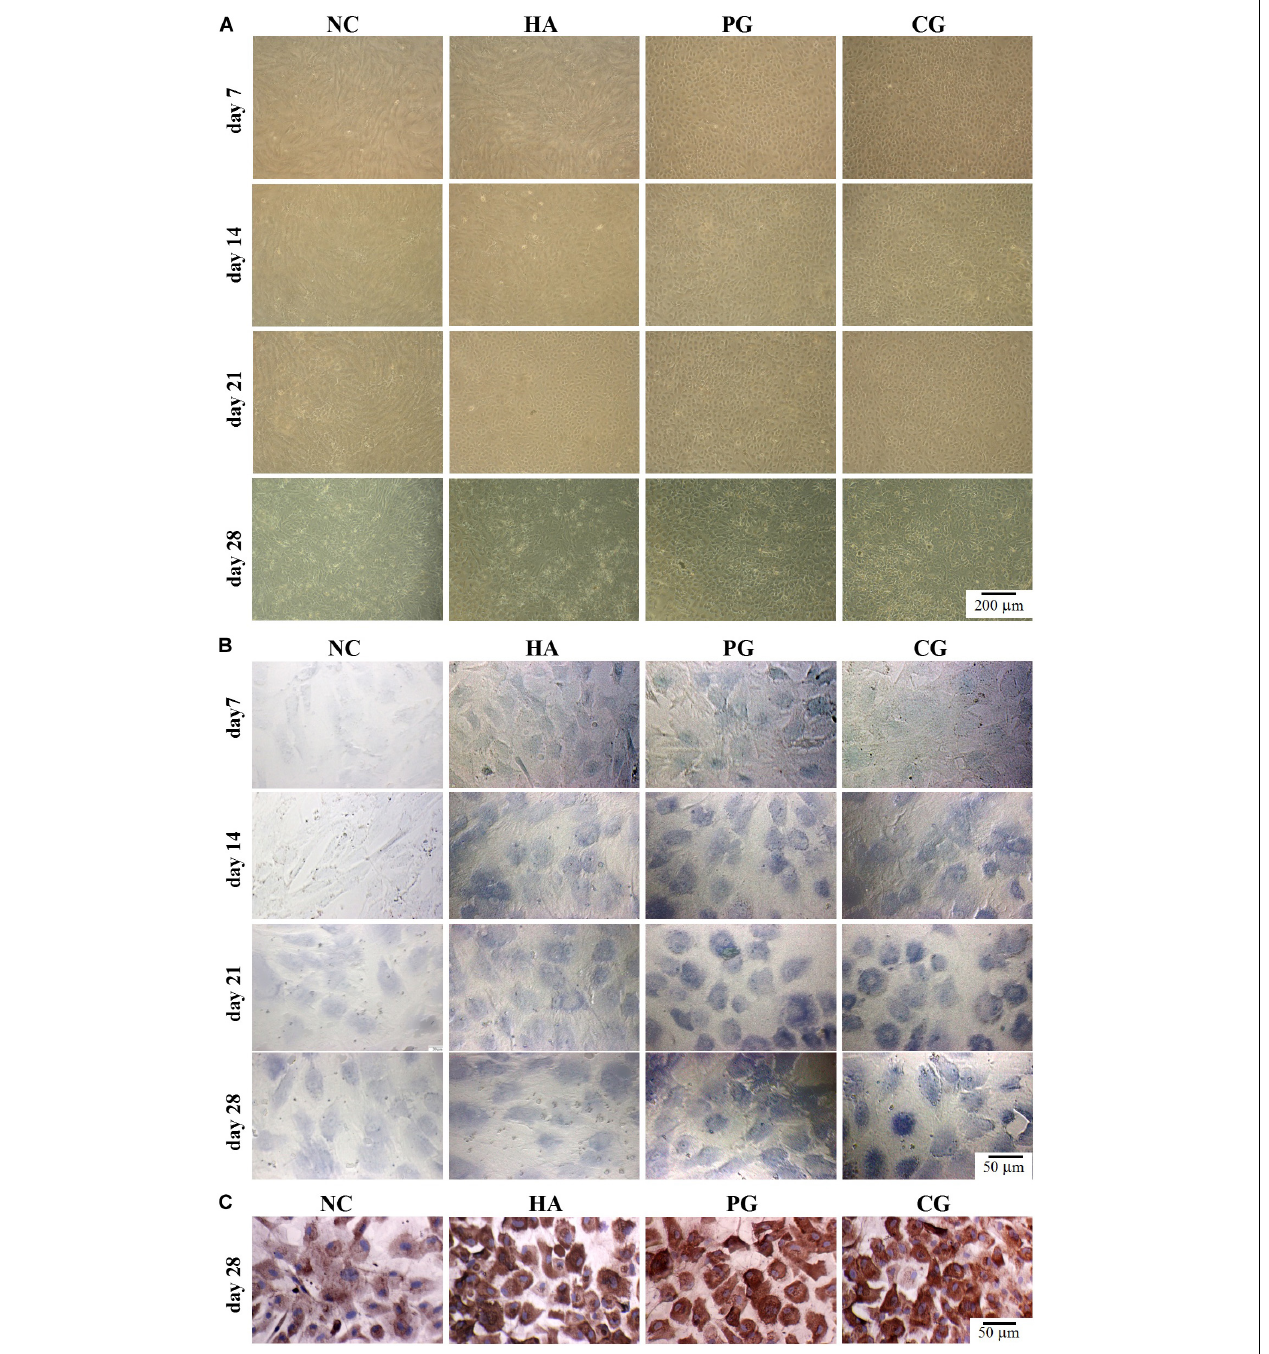
FIGURE 2 | Visual observations of hAMSCs differentiating into chondrocytes in vitro . (A) Morphology. (B) Accumulation of glycosaminoglycan by toluidine blue staining. (C) Expression of collagen II by immunohistochemical staining. NC, HG-DMEM; PG, chondrogenic differentiation medium; HA, HG-DMEM + 0.05 mg/mL HA; CG, 0.05 mg/mL HA + chondrogenic differentiation